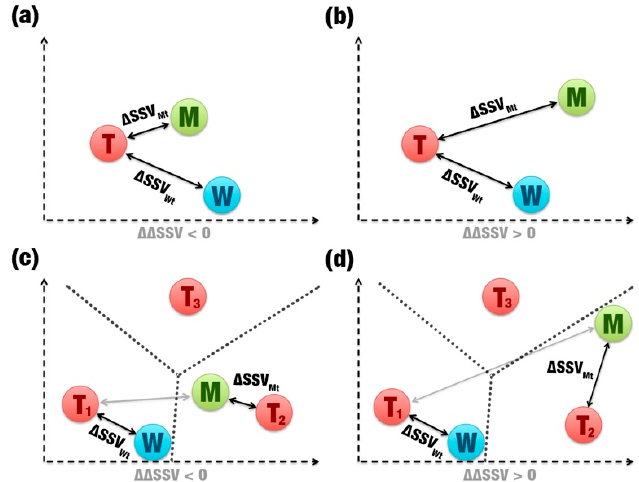
Figure 4. Two-dimensional representation of comparisons between signatures. ( a ) and ( b ) show simple comparisons (same template). ( c ) and ( d ) show comparisons with two different templates (T 1 , T 2 , and T 3 ). The gray arrows highlight that a second template was used. The dotted lines are used to show whether a mutation becomes more similar to a second template than the original. ( a ) and ( c ) represent beneficial mutations. ( b ) and ( d ) represent non-beneficial mutations.